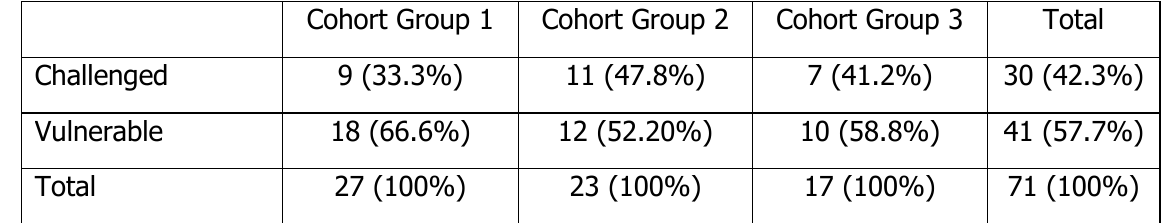
African American Female Cohort Group Empowerment